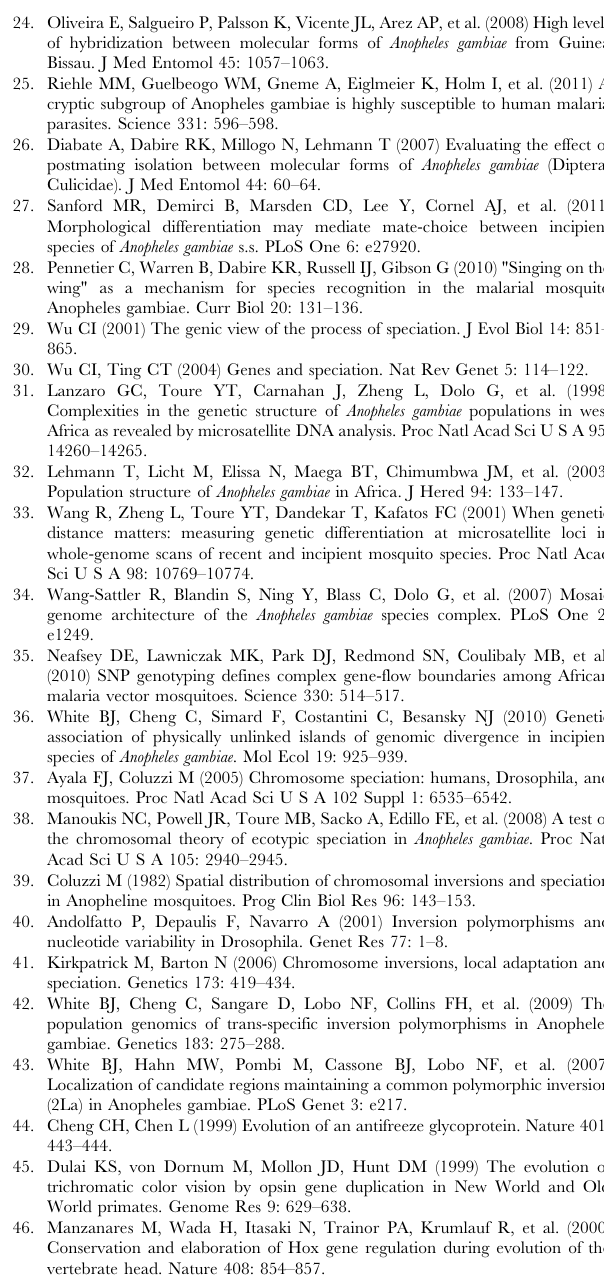
Figure S6 Illustration of probe hybridization character- istics in perfect match microarray. (PDF) File S1 Individual karyotypes of collected specimens from 15 sites shown in Figure